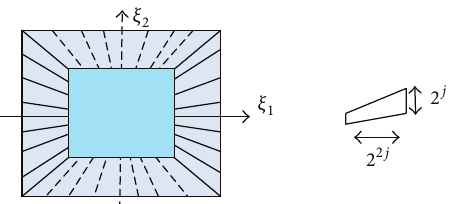
Figure 3: (a) The tiling of the frequency plane. The tiling of horizontal cone is illustrated in solid line; the tiling of vertical cone is in dashed line. (b) Frequency support of shearlet satisfies parabolic scaling ( 𝑗 -decomposition level). The Figure shows only the support for 𝜉 1 > 0 ; the other half of the support, for 𝜉 1 < 0 , is symmetrical.